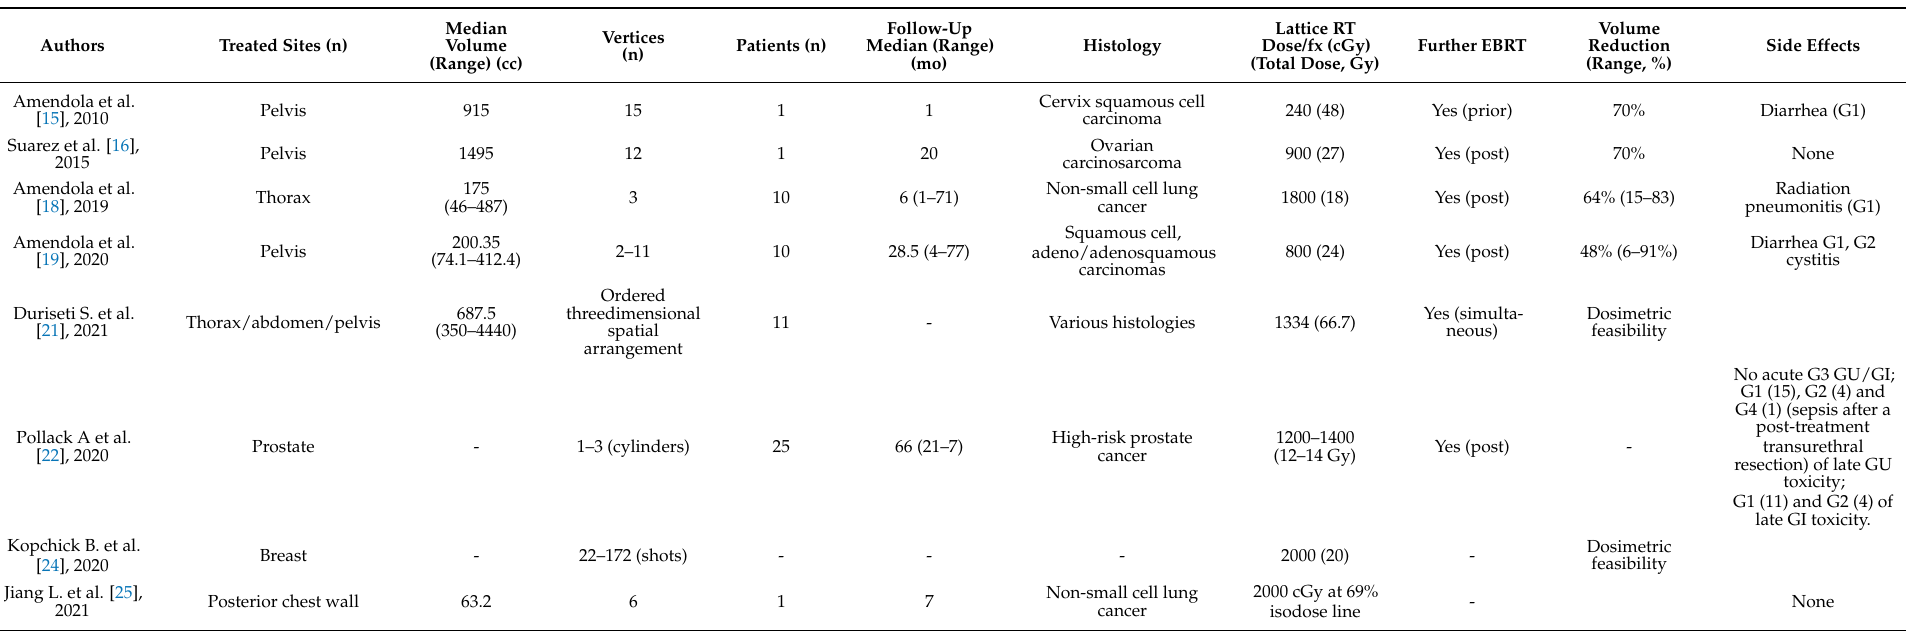
Table 1. Summary of experiences with lattice radiotherapy. Toxicity outcomes reported according to RTOG scale. GI, gastrointestinal; GU,